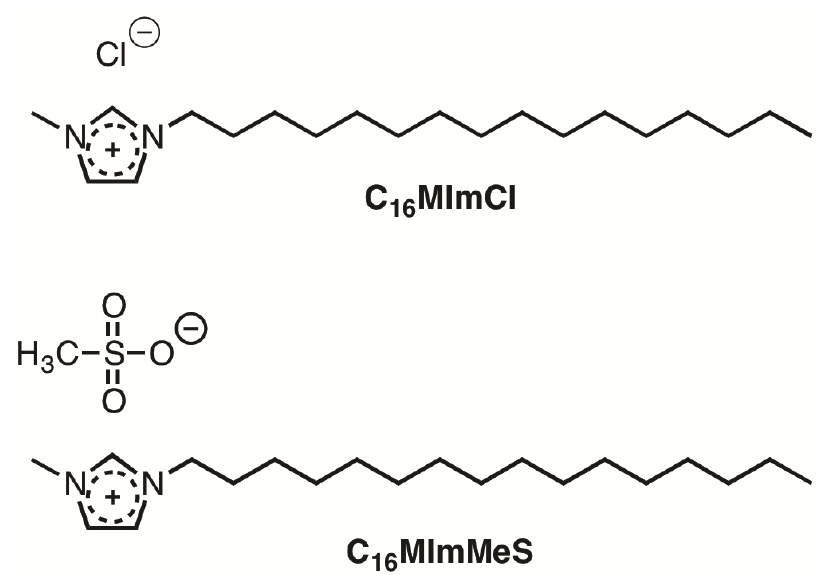
Figure 1. ISs C 16 MImCl and C 16 MImMeS applied in this study.